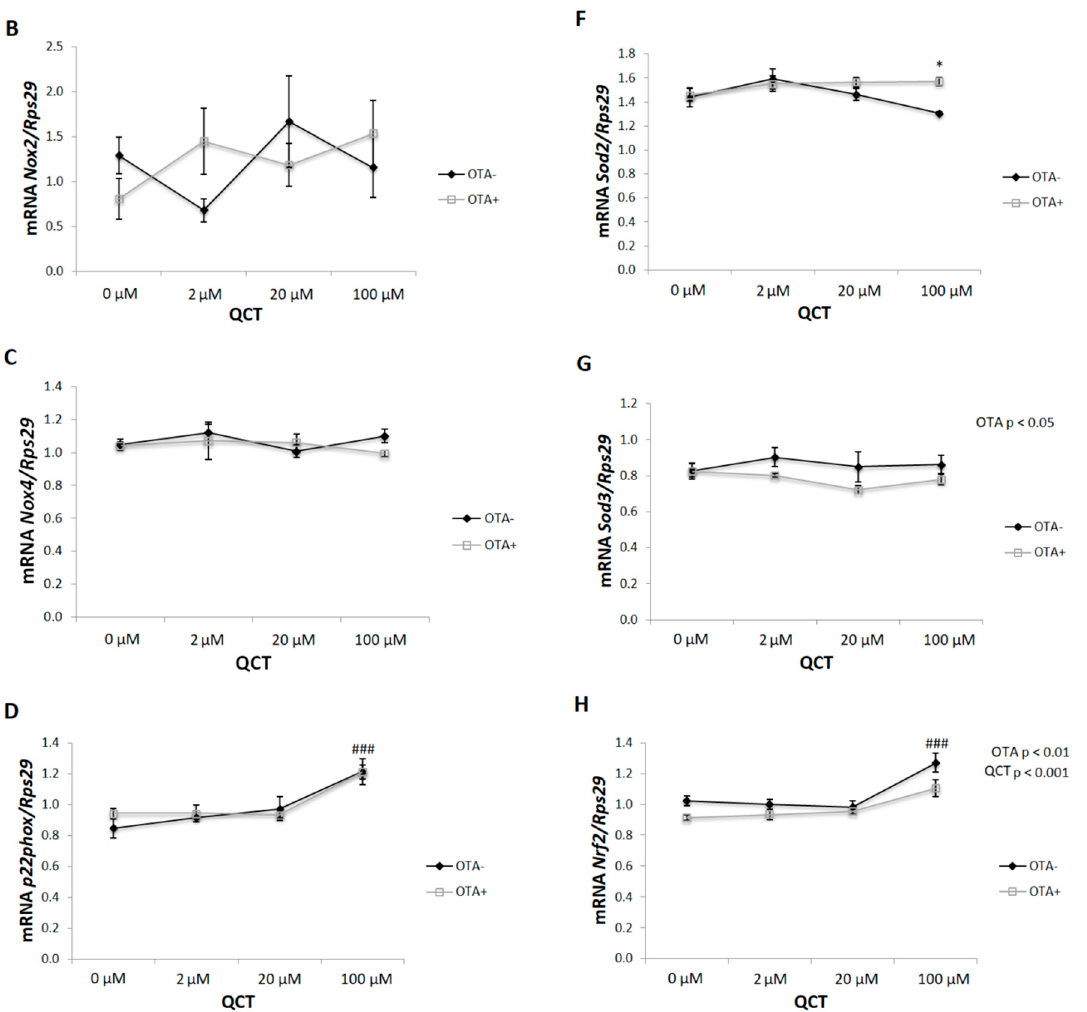
Figure 6. Production of reactive oxygen species (ROS) in differentiated primary rat preadipocytes cultured with (OTA + ) or without the addition of ochratoxin A (OTA-) in cell culture medium and with the addition of quercetin (QCT) at various concentrations. The production of ROS was determined using a commercially available kit, and is expressed as a percentage of CM-H2DCFDA fluorescence relative to control ( A ). The expressions of NADPH oxidase 2 ( Nox2 ; B ), Nox4 ( C ), p22 ( D ), superoxide dismutase 1 ( Sod1 ; E ), Sod2 ( F ), Sod3 ( G ) and nuclear factor erythroid 2–related factor 2 ( Nrf2 ; H ) were determined by real-time PCR. Data were normalized to the gene expression of 40S ribosomal protein S29 (Rps29), the expression of which was not altered by the treatments. The results, presented as mean ± mean error (SEM), were analyzed by two-way ANOVA with factors QCT and OTA, followed by Bonferroni post-hoc test. The level of statistical significance considered for factor OTA was * p < 0.05; *** p < 0.001, and for factor QCT ## p < 0.01; ### p < 0.001.